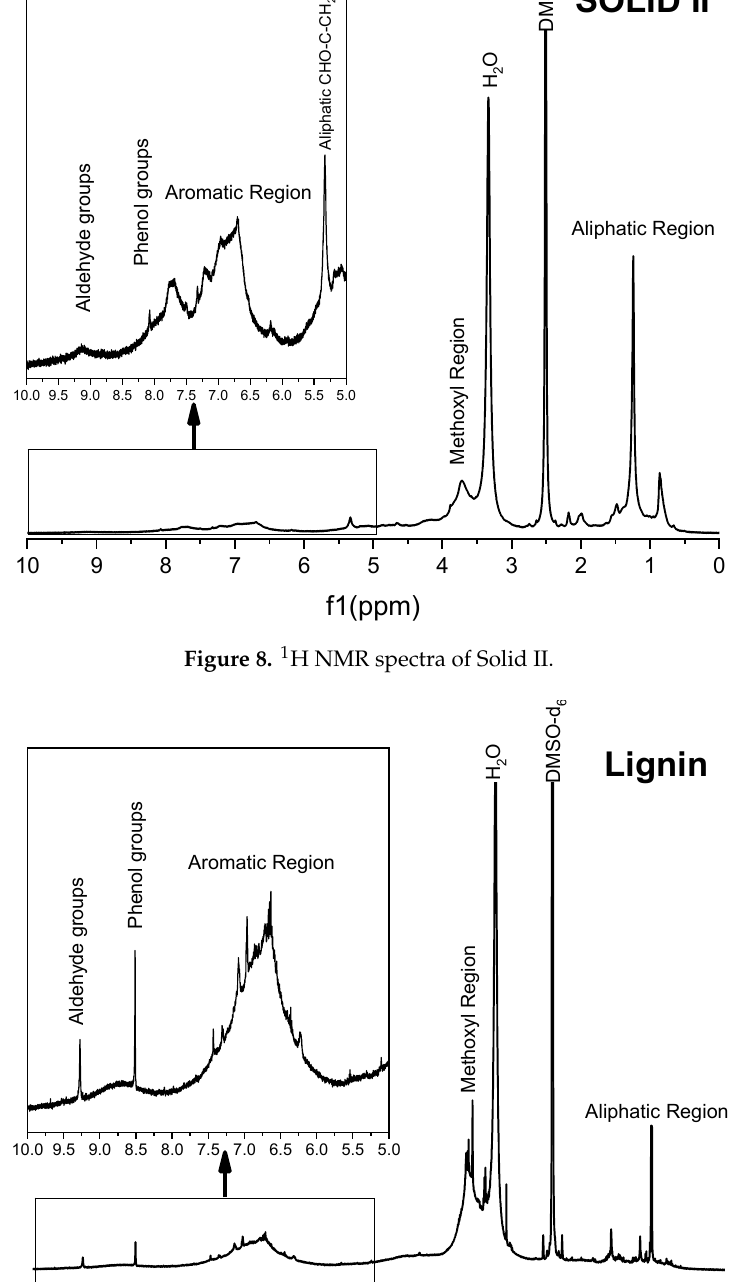
Figure 7. 1 H NMR spectrum of commercial xylans.